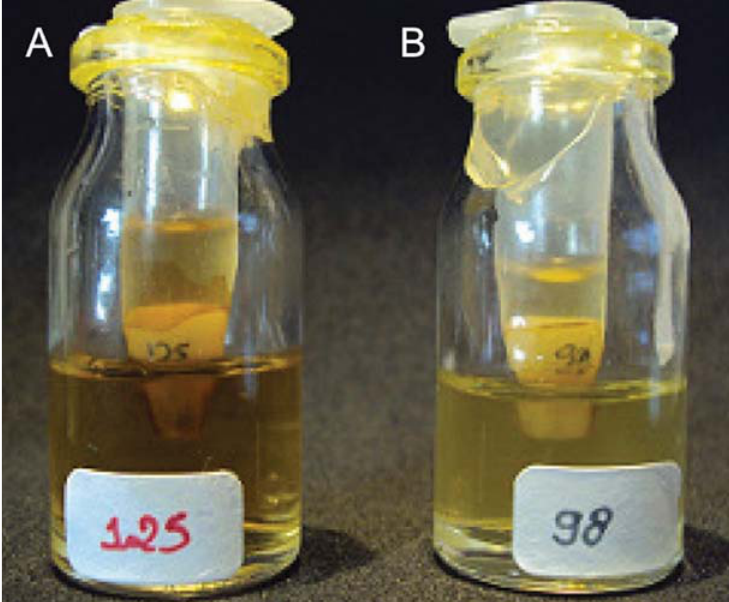
Figure 2- Representative leakage apparatus used for the experiment. Negative microbial growth is shown in A and positive microbial growth can be observed in